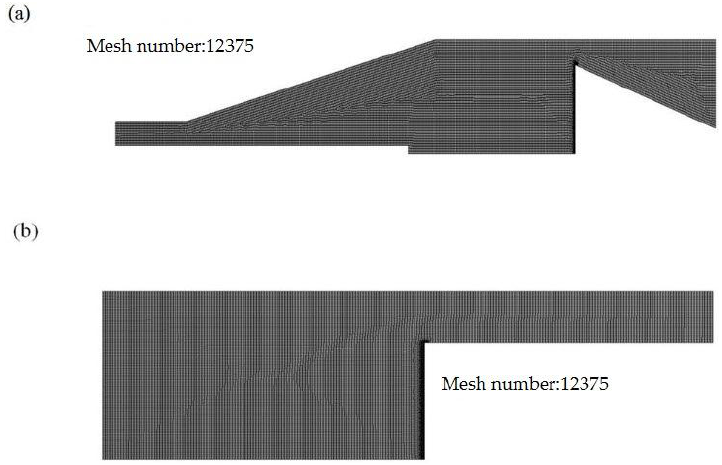
Figure 12. Schematic diagram of mesh for ( a ) Experiment 1 [10] and ( b ) Experiment 2 [11].